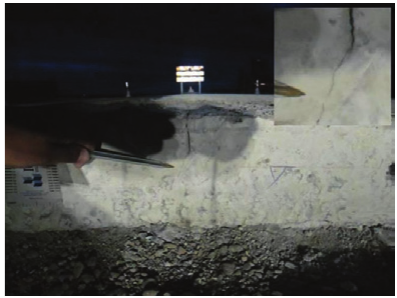
Fig. 2. Crack under longitudinal joint in JPCP (7 m width), Tierra del Fuego Province. 2:00 am – temperature at the surface of the pavement 10 °C